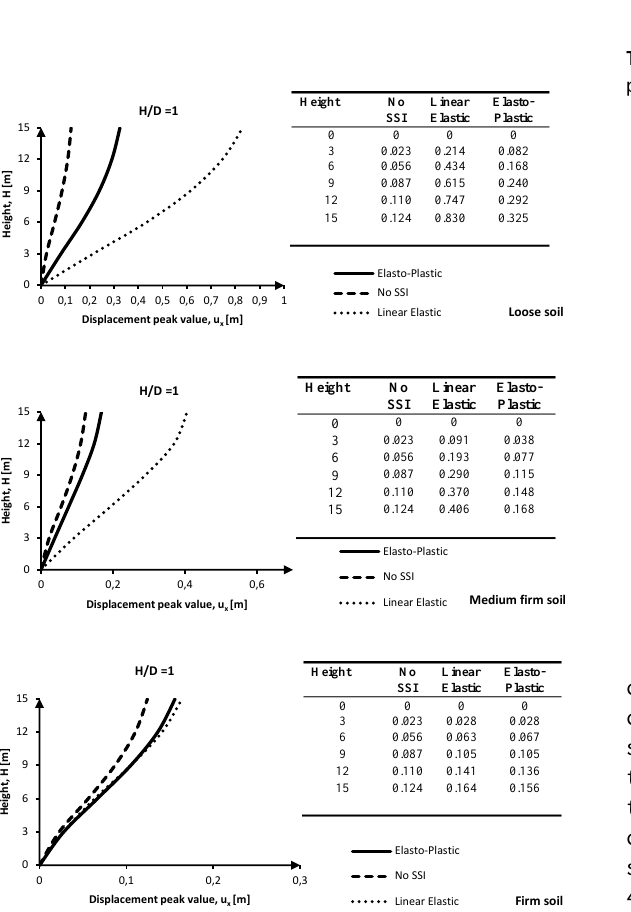
Fig. 3. Variation of peak lateral response of the building depending on different soil conditions in the case of H/D = 1 for the 1989 Loma Prieta earthquake input motion.